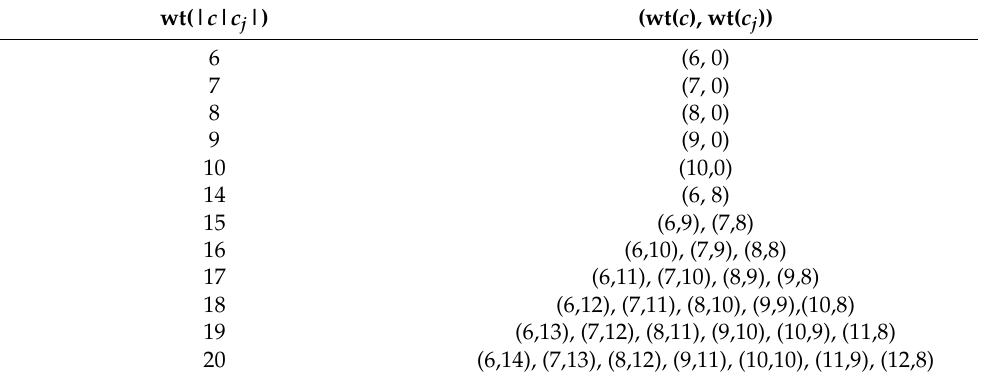
( j ) w of codeword weight wt